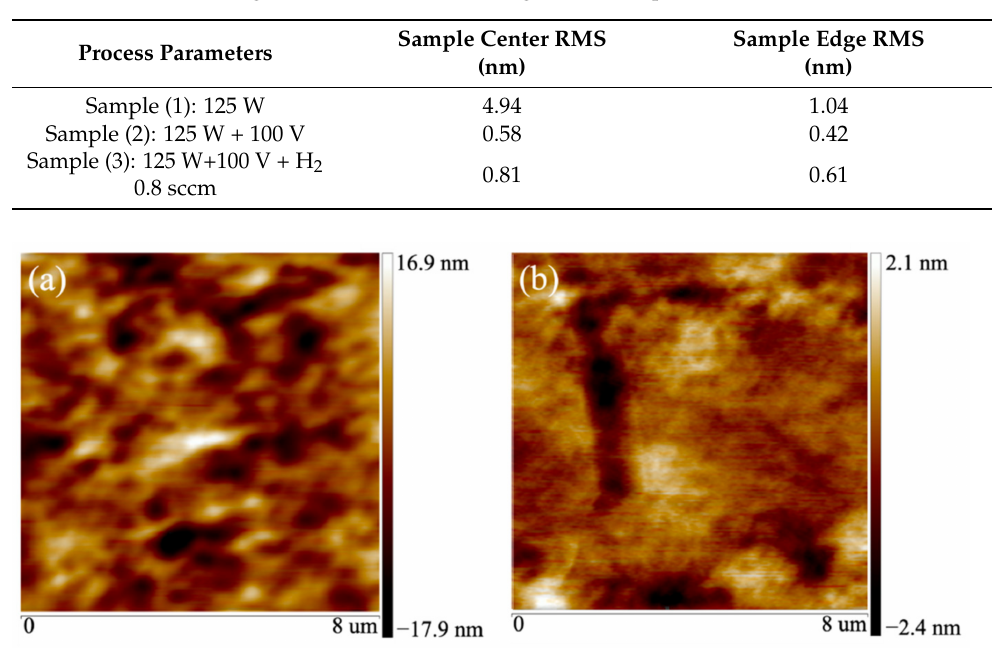
Table 2. The surface roughness of the center and edge of the samples.